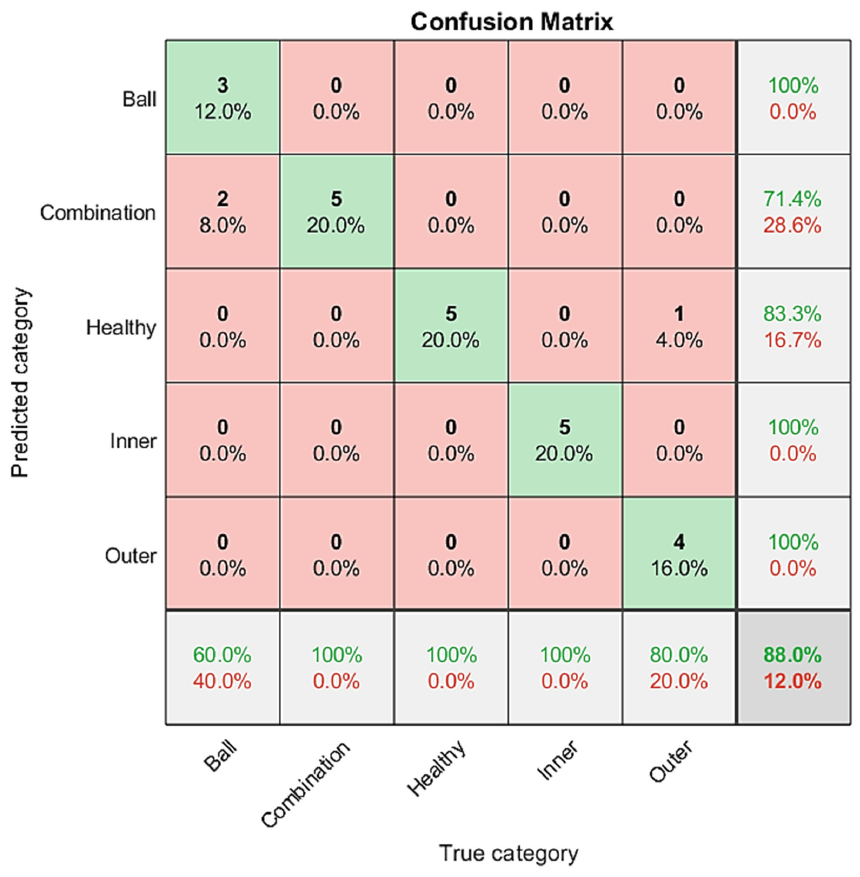
Figure 14. MobileNet classification results in confusion matrix; the accuracy rate is 88%.